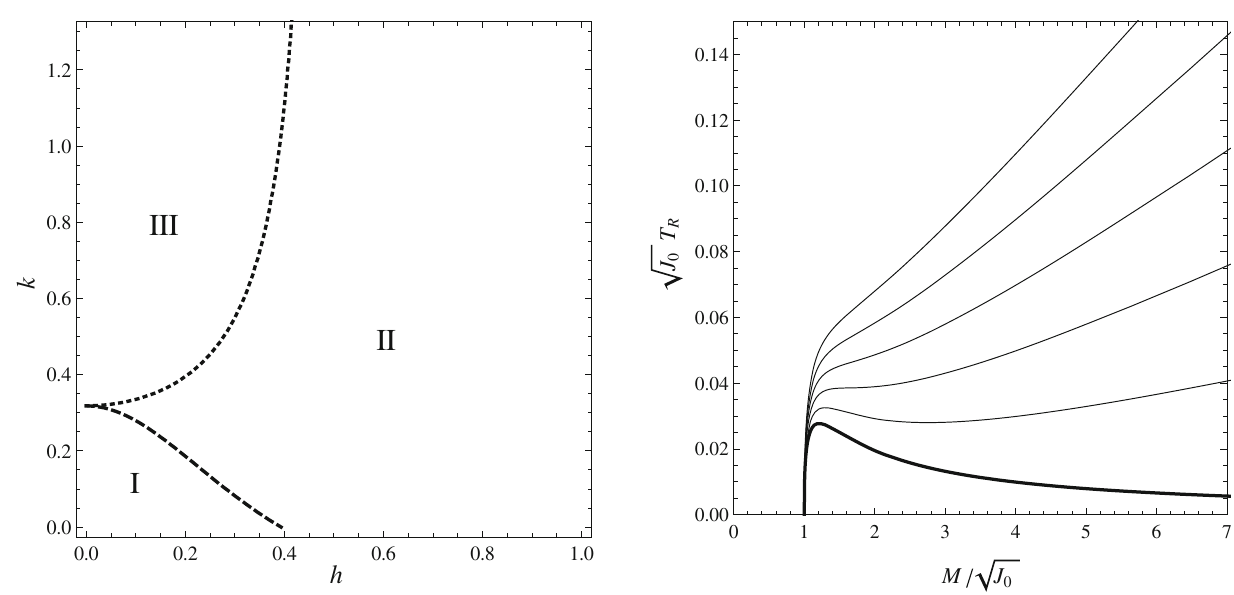
Fig. 4 Plots of the Rényi temperature against the mass-energy param- eter of Kerr black holes at fixed J = J 0 with λ J 0 = 0 . 05, 0.04, 0.03, 0.02 and 0.01 parameter values starting from the top, respectively. The bottom, bold curve belongs to the standard Hawking temperature of the black hole in the Boltzmann